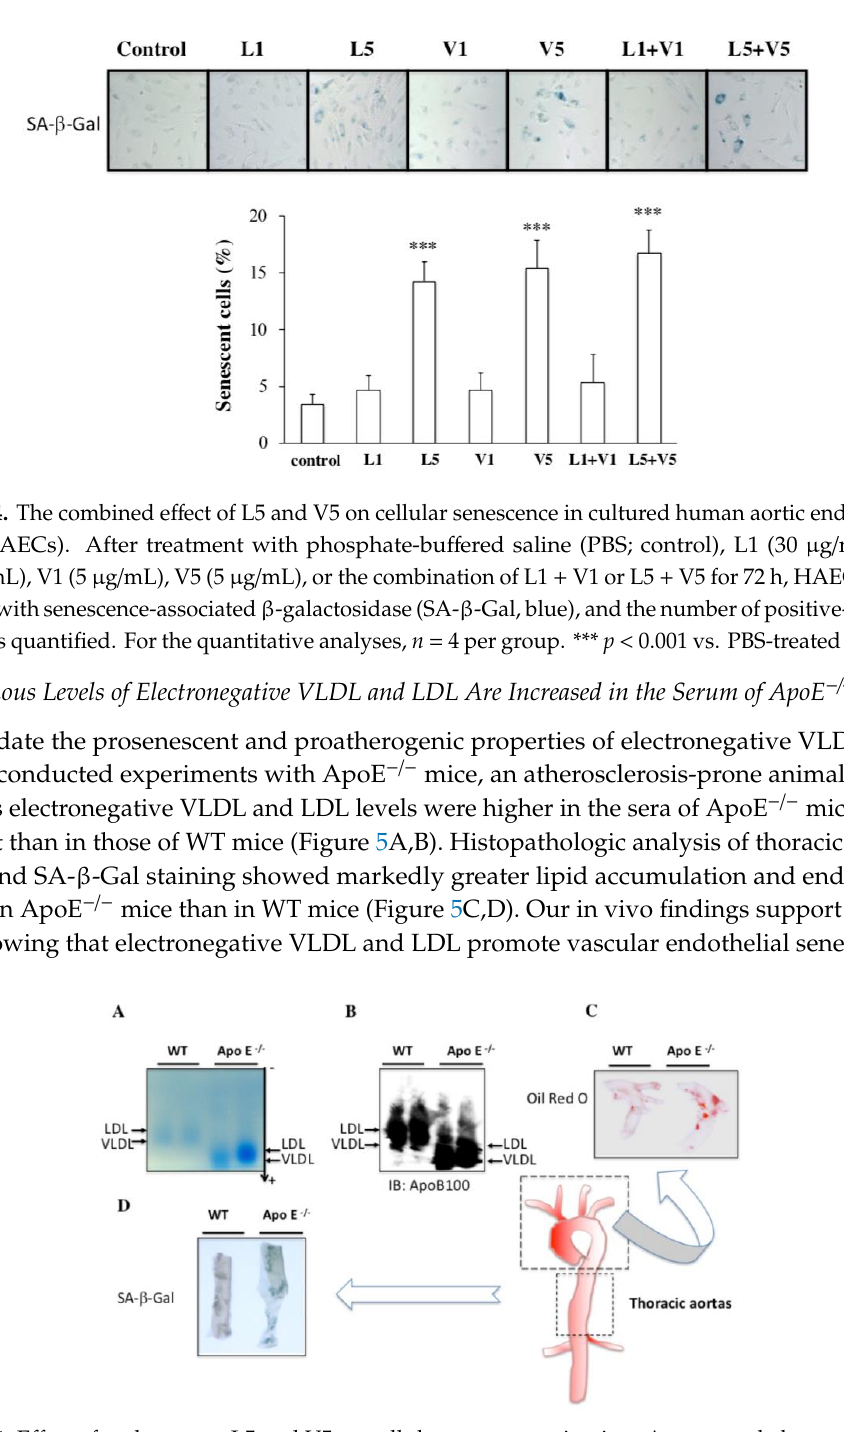
Figure 5. Effect of endogenous L5 and V5 on cellular senescence in vivo. Agarose gel electrophoresis ( A ) and Western blot analysis ( B ) with anti-ApoB100 show the difference between blood serum from wild-type (WT) and ApoE − / − mice fed with a high-fat diet for 15 weeks. Oil Red O ( C ) and senescence-associated β -galactosidase (SA- β -Gal) ( D ) staining of aortas from WT and ApoE − / − mice fed with a high-fat diet. WT (B57CL/6) mice were used as controls.